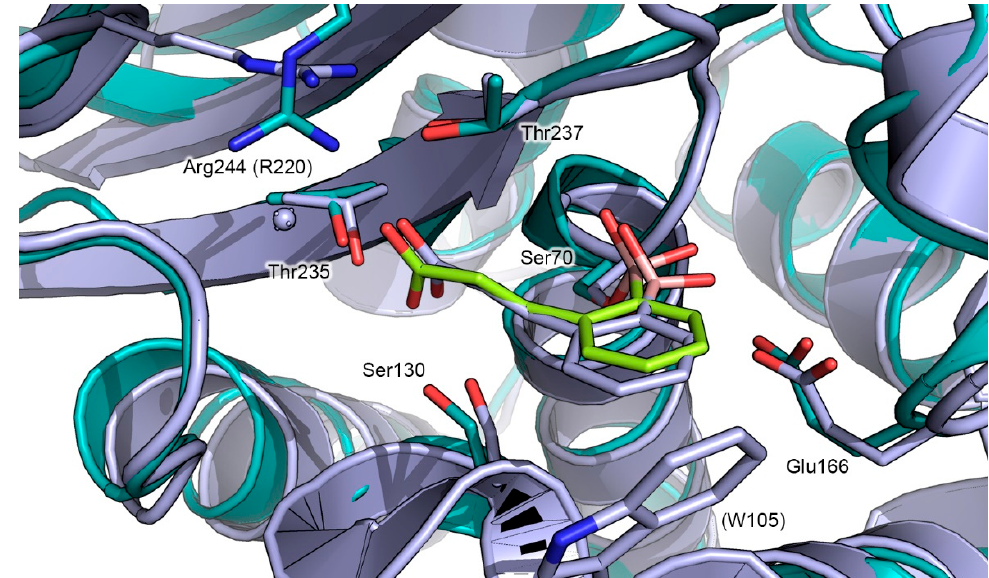
Figure 4. Superimposition of the predicted docking pose of compound 2 (green sticks) in complex with GES-5 protein (PDB ID: 6Q35, teal cartoon), with the X-ray structure of 2 (indigo sticks) in complex with KPC-2 (PDB ID: 5LL7, indigo cartoon) [24]. Residues involved in binding are shown as sticks, using the color code adopted for the respective proteins. The corresponding amino acidic numeration for KPC-2 is reported in parenthesis. Heteroatoms are color-coded (oxygen in red, nitrogen in blue, boron in pink).